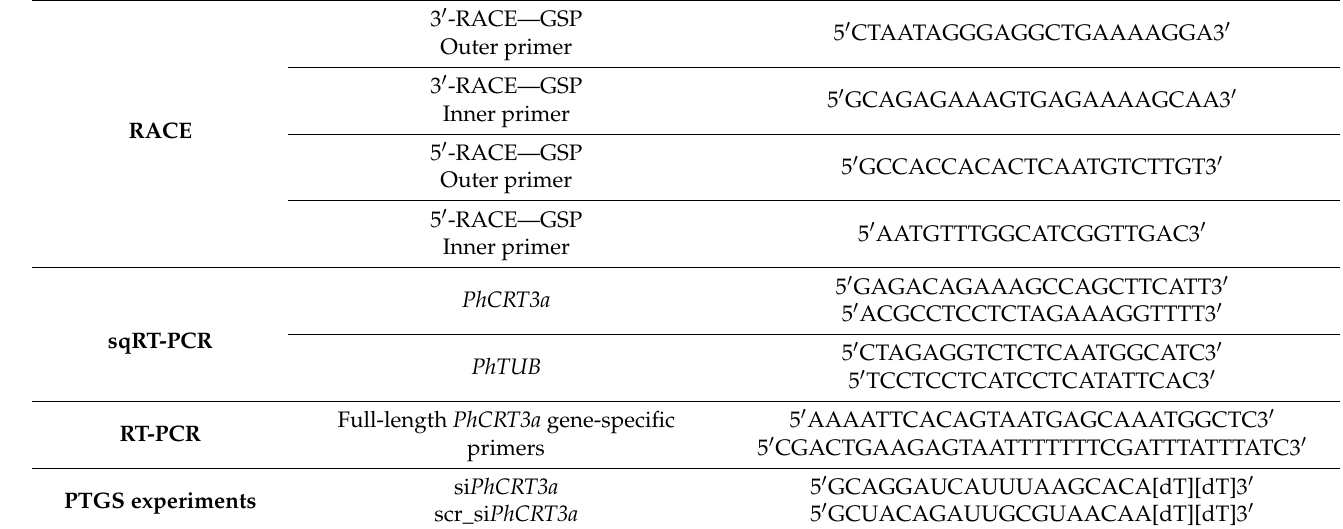
Table 1. List of sequences used in RACE, sqRT-PCR, RT-PCR, and PTGS